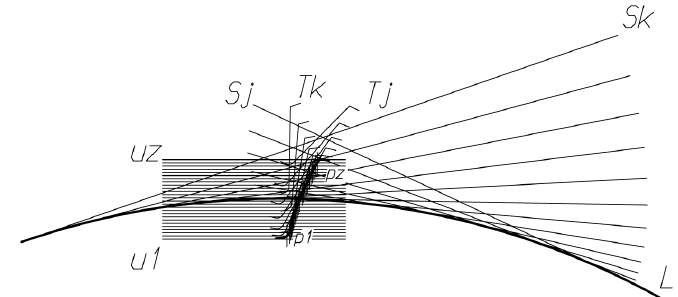
Figure 14. Evaluation of a tooth’s form.